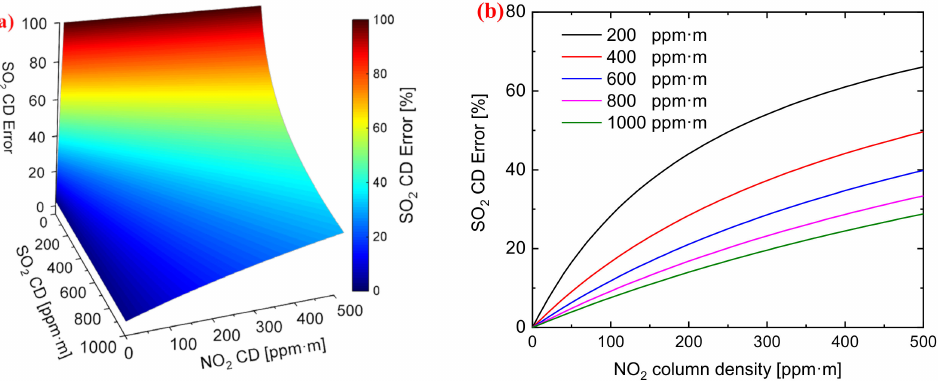
Figure 2. ( a ) Result of SO 2 column density (CD) error under the influence of NO 2 CD; ( b ) Error varying with NO 2 CD for five different SO 2 CDs (200 ppm · m, 400 ppm · m, 600 ppm · m, 800 ppm · m, and 1000 ppm · m